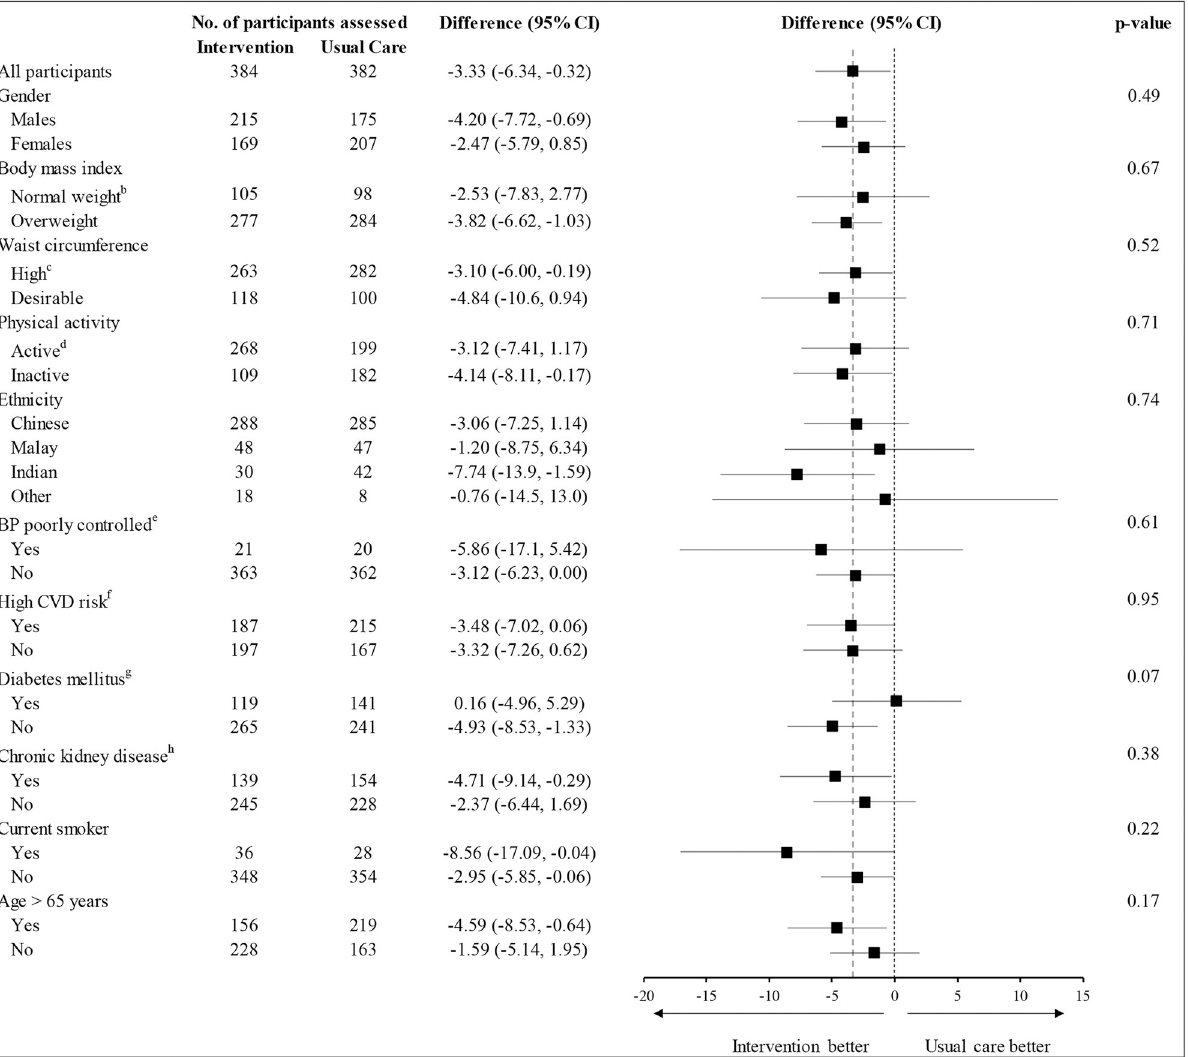
Fig 3. Subgroup analyses for SBP at 24 months, according to participant characteristics at baseline a . a Subgroups defined based on the status of the participants at the time of baseline interview. b Normal weight is defined as BMI < 23.5 kg/m 2 per Asian cutoffs. c High waist circumference was defined as waist circumference of � 90 cm in males and � 80 cm in females. d Physical activity was assessed using the IPAQ score. The IPAQ Group, 2005. e Defined as SBP � 160 mmHg and DBP � 100 mmHg. f Defined using the standardized physician management checklist developed for the study. The participant is categorized as high CVD risk if any of the following criteria is met: high CVD risk by FRS adapted for Singapore � 20, diabetes, ACR > 34 mg/mmol, eGFR < 60 ml/minute/1.73 m 2 , physician diagnosed heart disease, and self-reported stroke. g Diabetes is defined as physician diagnosed